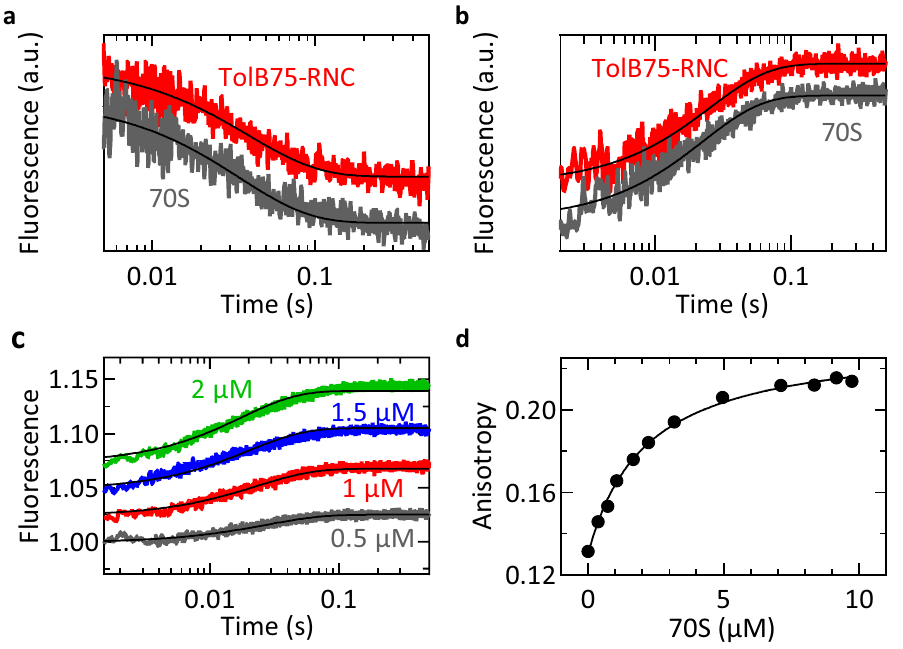
Figure 3. Interaction of PDF with TolB75-RNC and vacant 70S ribosomes. In ( a , b ) time courses are shifted on the Y-axis for visual clarity. ( a ) Time courses of PDF dissociation from the ribosome. Time courses of 70S– PDF(Bpy) or RNC–PDF(Bpy) (150 nM) dissociation upon addition of excess unlabeled PDF (15 µM) were measured in a stopped-flow apparatus at 10 °C. Eight technical replicates were averaged for each trace and smooth lines represent single-exponential fits. ( b ) Association time courses. Binding was monitored upon rapid mixing of PDF(Bpy) (300 nM) with 70S ribosomes or TolB75-RNC (420 nM) at 10 °C. Six technical replicates were averaged and evaluated by single-exponential fitting (smooth lines). ( c ) Binding of PDF(Bpy) (100 nM) to 70S ribosomes (0.5–2 µM) monitored by fluorescence intensity changes at 10 °C. Each time course represents an average of seven technical replicates. The smooth lines result from global fitting to a one-step binding model (Table 2). ( d ) Binding of PDF to 70S ribosomes monitored by changes in fluorescence anisotropy of PDF(Bpy) (200 nM). The data were fitted to a hyperbolic function.